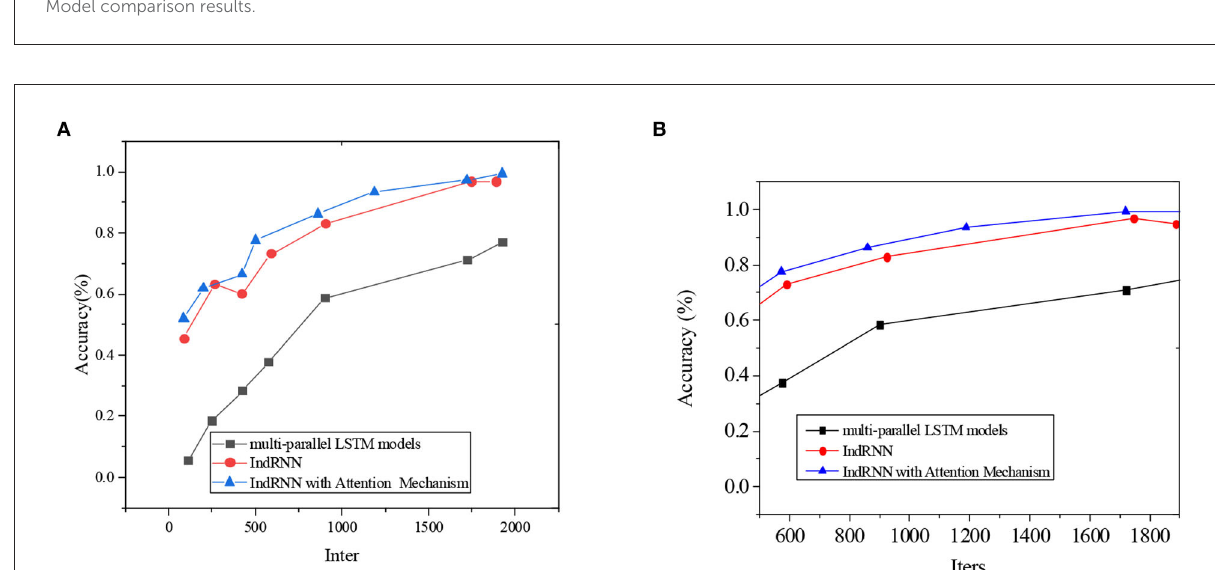
FIGURE9 Model comparison results.